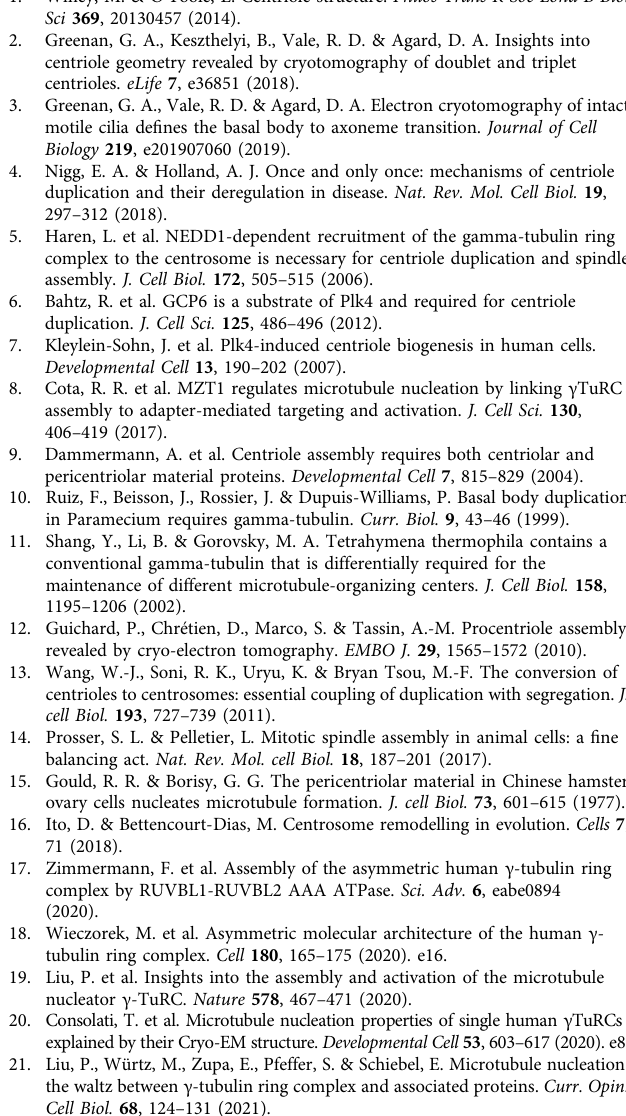
Fig. 6 POC5 and γ TuRC are required for ciliogenesis. a Control and POC5 RNAi RPE1 cells treated and stained as indicated. Scale bar, 10 µ m (cells) or 2 µ m (magni fi cations). b Percentage of ciliated RPE1 WT and RPE1 p53 KO cells treated as in ( a ). Data points are from 3 independent experiments, 118-202 WT and 82-113 p53 KO cells per condition and experiment ( p ( p53 + / + ) < 2.22e-16, p ( p53 -/-) < 2.22e-16, generalized linear model with binomial distribution). c Serum-starved control (WT) or patient (AII-1) fi broblasts stained for acetylated α -tubulin and either γ -tubulin, ODF2 or ninein and DNA. Insets show magni fi ed centrosome regions. Scale bar, 5 µ m. d Percentage of ciliated control (WT) or patient (AII-1) fi broblasts as in ( c ). Data points are from 4 independent experiments, 99-122 cells per condition and experiment ( p (WT) < 2.22e-16, generalized linear model with binomial distribution). e Cilia length in cells as in ( c ). The box plot contains pooled data from 3 independent experiments, 13 – 26 cilia per condition and experiment ( p < 2.22e-16, generalized linear model). f Serum-starved control (WT) or patient (AII-1) fi broblasts stained as indicated in U-ExM. White arrowheads indicate CEP164 distal appendage staining, cyan arrowheads mark discontinuous luminal GCP4 signal. Scale bar, 2 µ m. g Centriole length in cells as in ( f ). The box plot contains pooled data from 3 independent experiments, 20 – 42 centrioles per condition and experiment ( p (WT ciliated/WT unciliated) = 0.64112, p (WT ciliated/AII-1 ciliated) = 0.99348, p (WT ciliated/AII-1 unciliated) = 0.99376, mixed-effects linear model). h Percentage of GCP4 centriole length coverage in cells as in ( f ). The box plot contains pooled data from 3 independent experiments, 20 – 42 centrioles per condition and experiment ( p (WT ciliated/WT unciliated) = 0.94869, p (WT ciliated/AII-1 ciliated) = 1.2652e-10, p (WT ciliated/AII-1 unciliated) <2.22e-16, mixed-effects linear model). ( b , c ): horizontal lines and error bars depict means and standard deviations, respectively. ( e , g , h ): Boxes extend from the 25th to the 75th percentile, horizontal lines indicate medians, whiskers depict the 10th and 90th percentiles. *** p < 0.001; n.s., not signi fi cant. Source data are provided as a Source Data fi